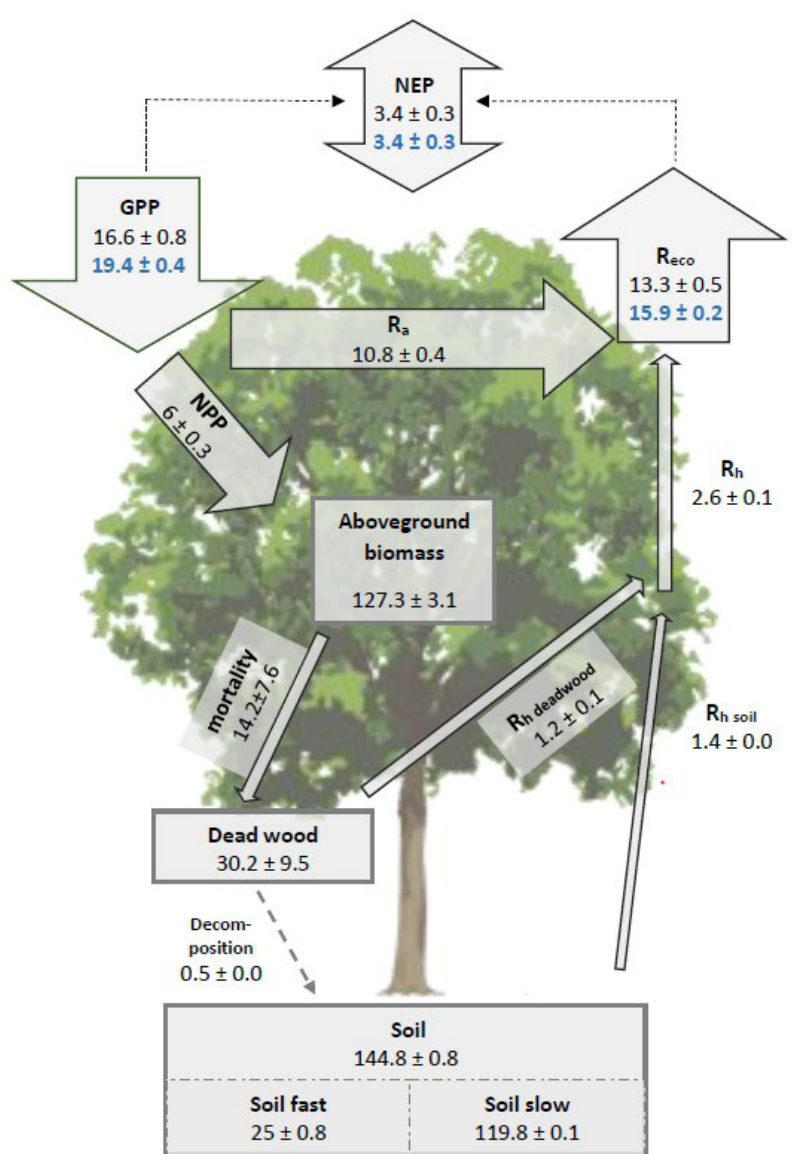
Figure 3. Measured and simulated major carbon stocks and fluxes in a temperate mixed deciduous forest in Germany (DE-HoH). All units are Mg C ha − 1 for stocks or Mg C ha − 1 a − 1 for fluxes. Blue values indicate measured carbon fluxes with the EC method. Black values indicate simulated values, and arrow sizes are related to the magnitude of the flux.